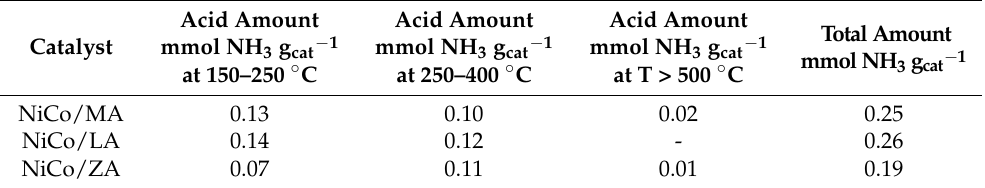
Table 2. Acidity measurements by NH 3 -TPD of the solids. The amount of ammonia desorbed per gram of catalyst was obtained from the temperature ranges to calculate the total concentration of acid